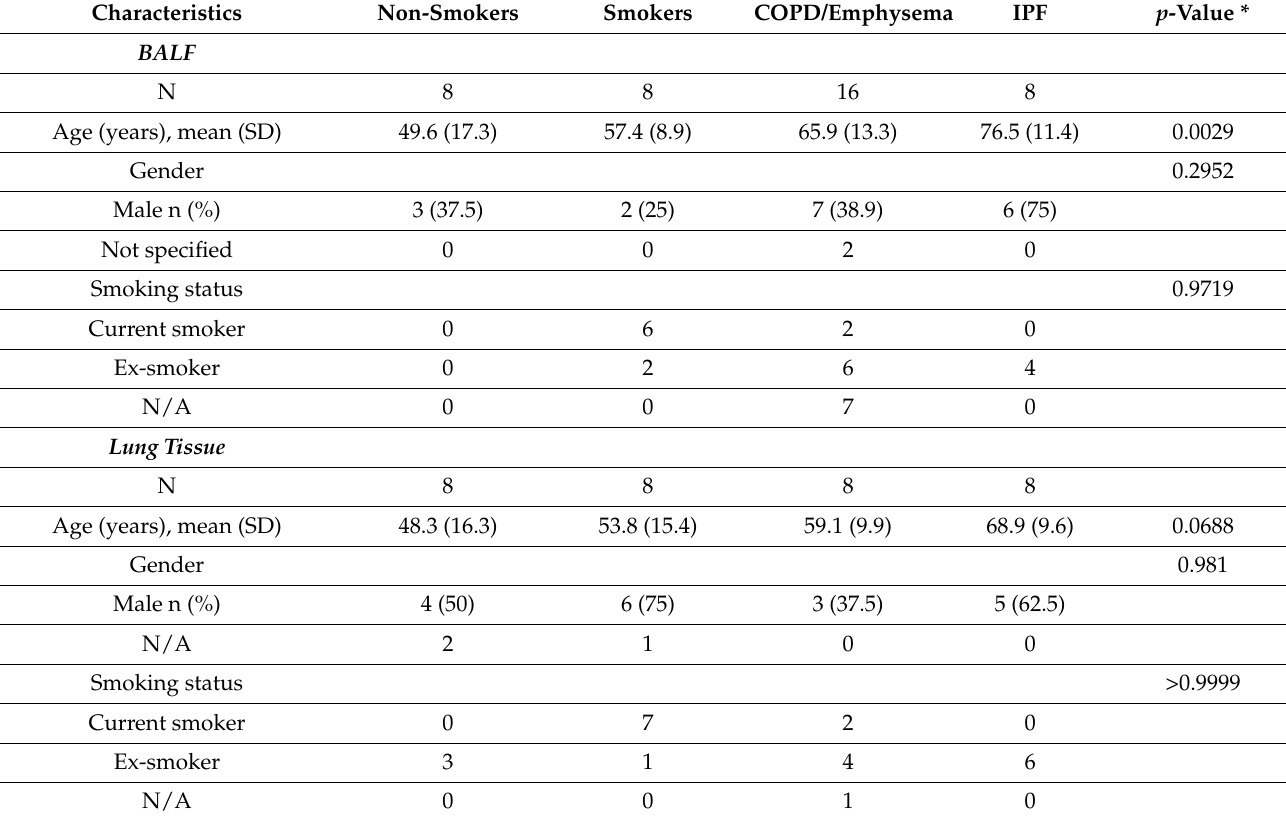
Table 5. Clinical characteristics of study